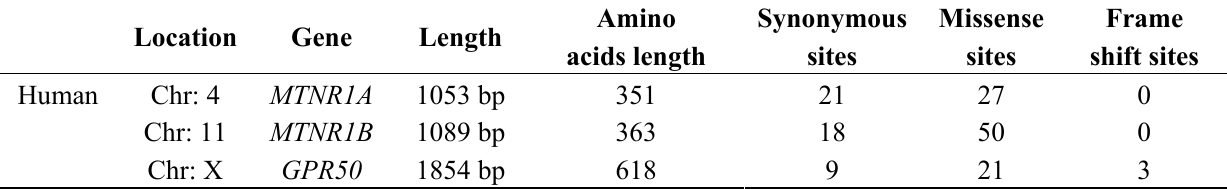
Table 1. Summary of polymorphisms of melatonin receptor genes in